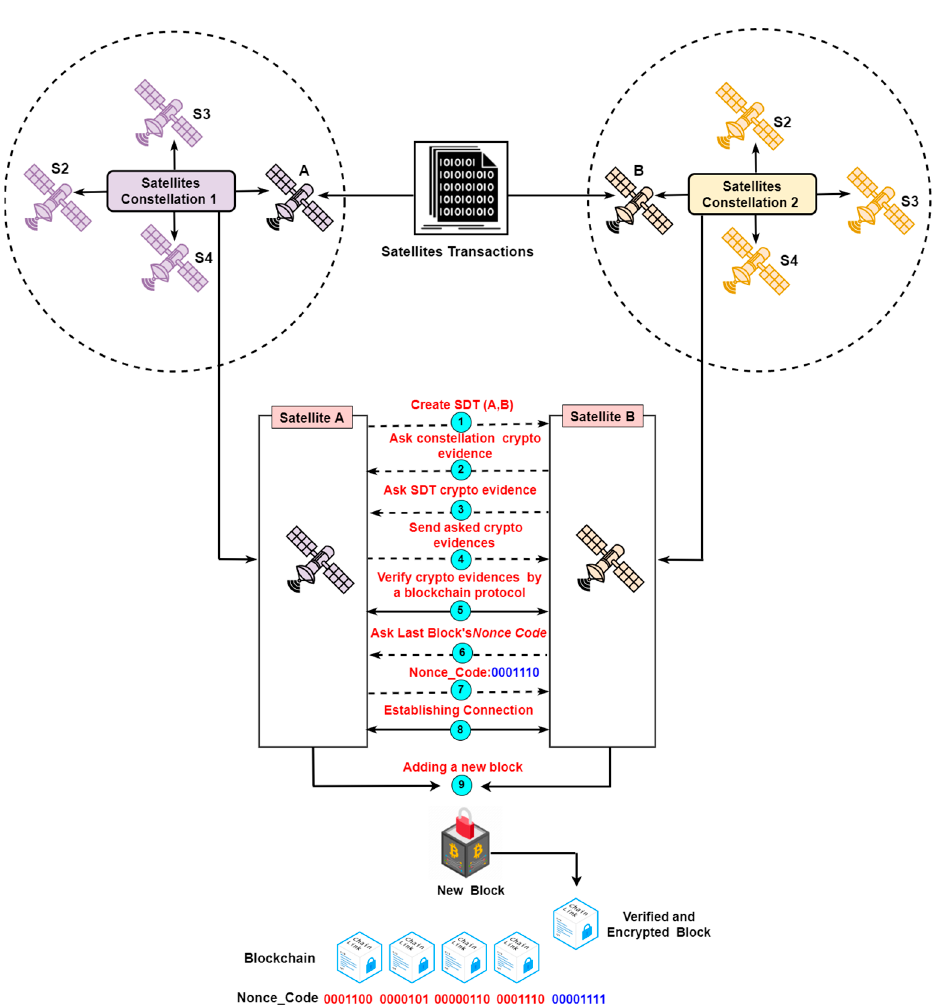
Figure 3. Proof of Space Transactions (PoST) protocol: Authenticating SDTs between two satellites within different satellite constellations.